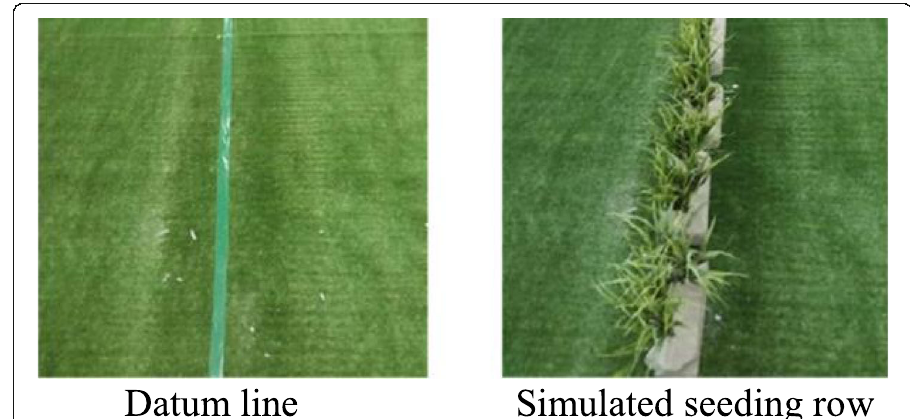
Fig. 11 Navigation test under interference background